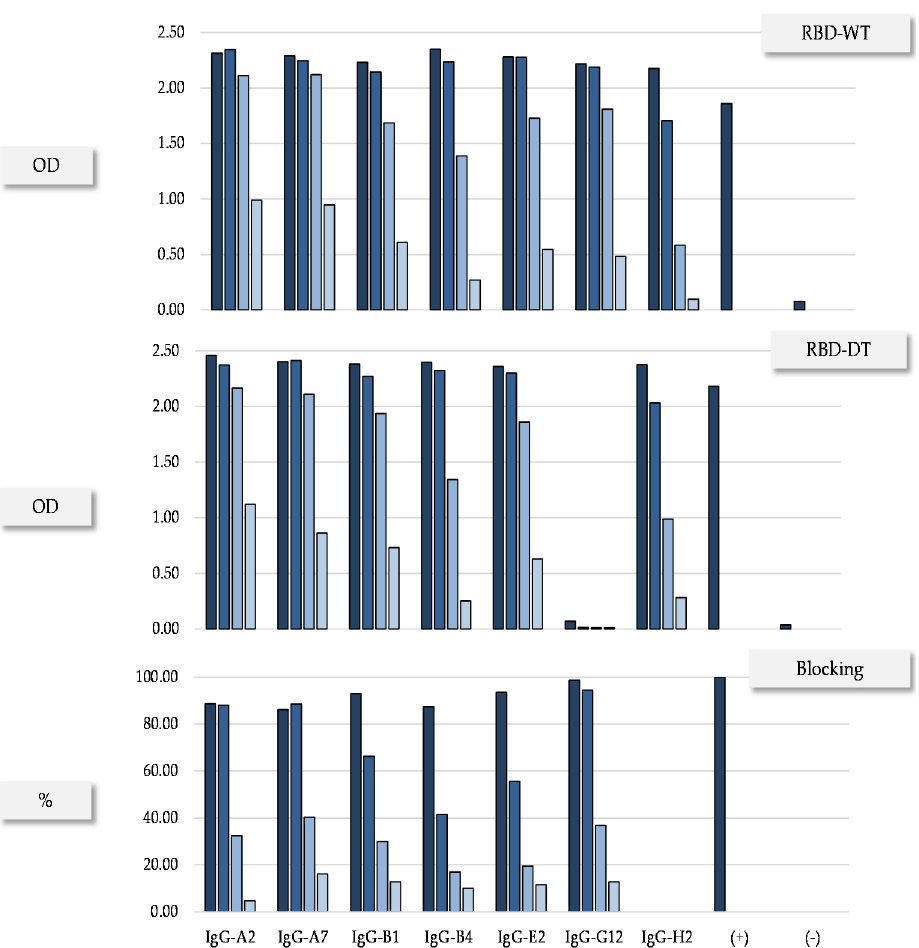
Figure 2. Confirmation of functional profile in HEK 293T of representative IgGs. Binding to RBD-WT, RBD-DT and blocking of the RBD:hACE2 interaction. The supernatants were evaluated in serial dilutions (1:10, 1.100, 1:1000 and 1:10,000) represented in different tones of blue. (+) and (–) indicate positive (P5E1-A6) and negative (D1.3) controls, respectively.